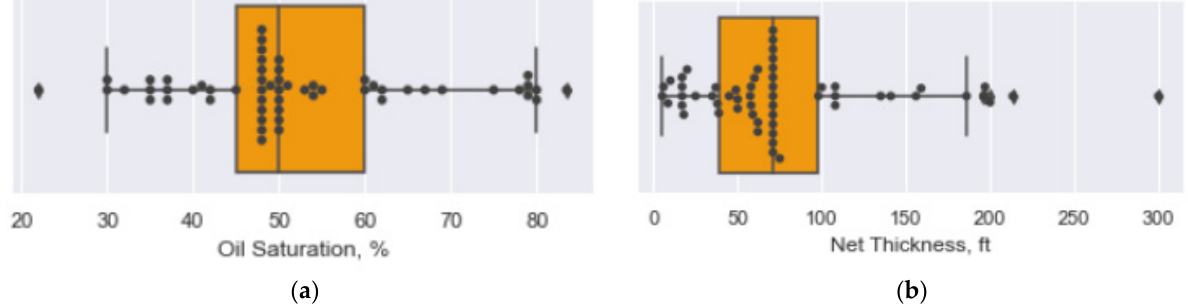
Figure 15. Miscible CO 2 -EOR box plot and swarm plot: ( a ) oil saturation and ( b ) net thickness.